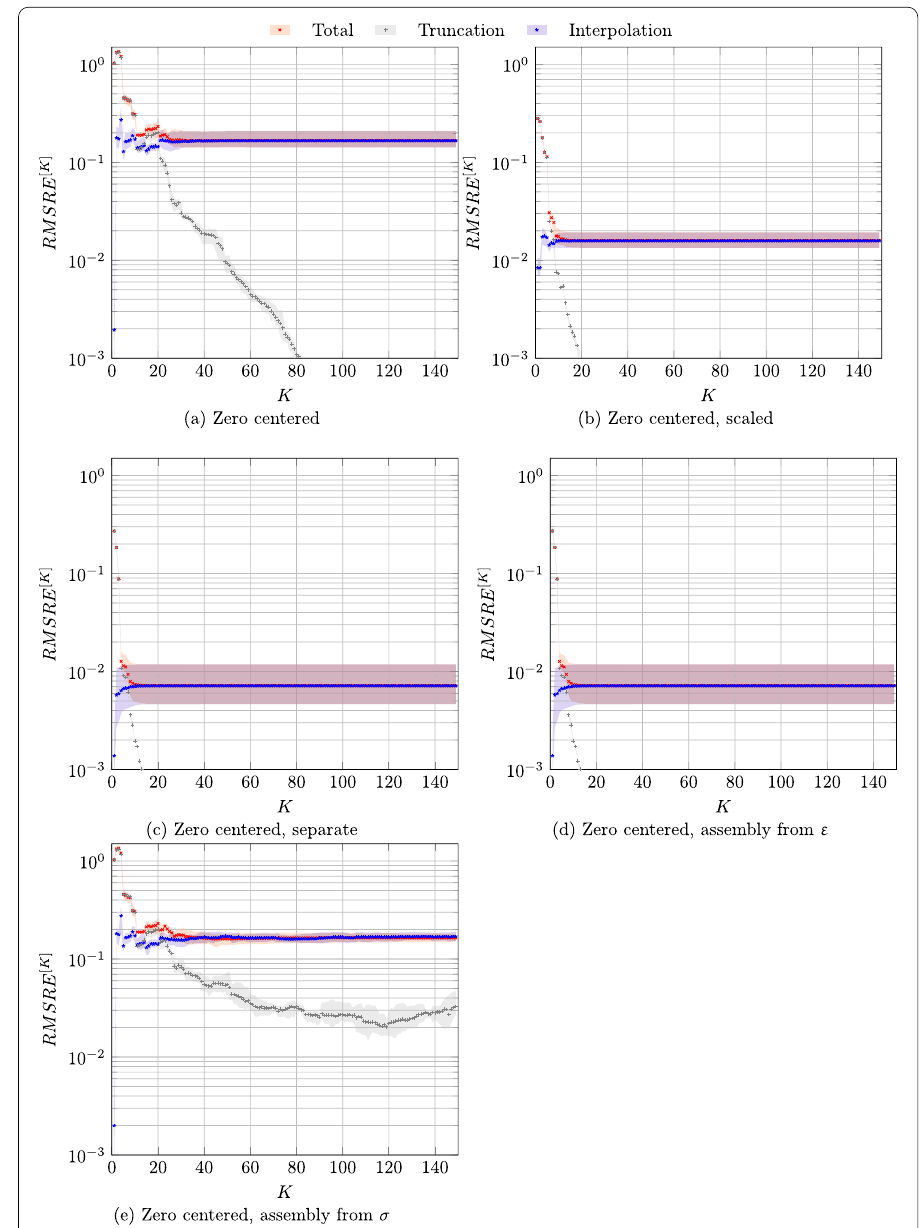
Fig. 8 RMSRE of the strain field of the pure bending problem using 5 different methods for surrogate model construction. The markers represents the mean over the 5 training sets. The shaded area represents the range over all training